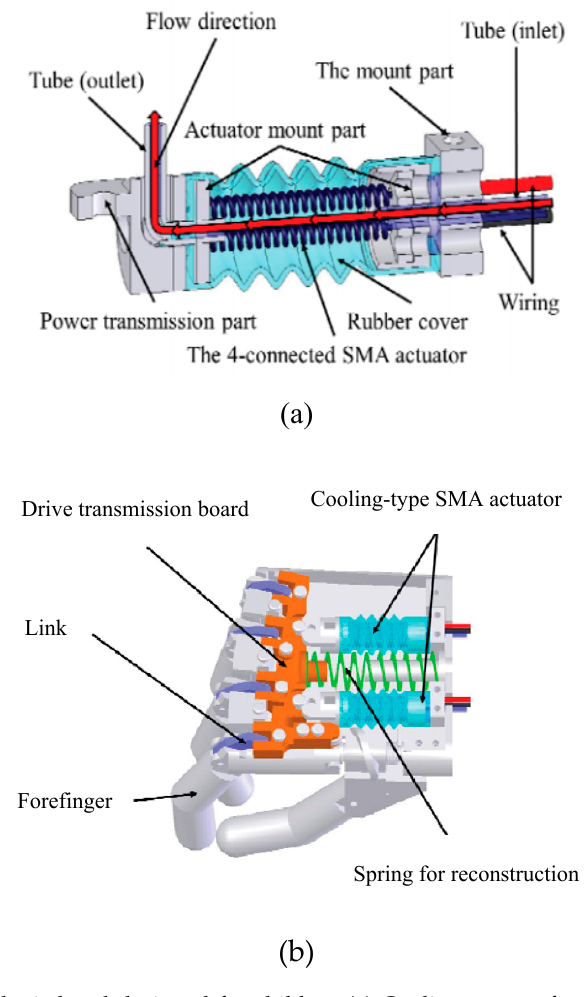
Figure 6. The prosthetic hand designed for children ( a ) Cooling system for achieving the higher actuation rate ( b ) the artificial hand structure [25].